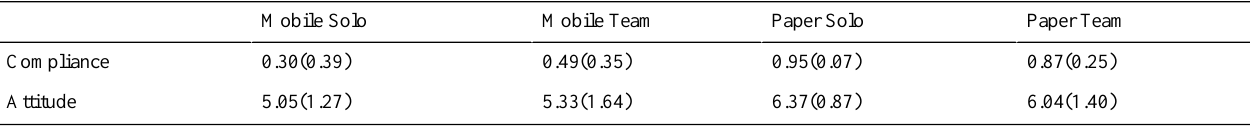
Table 2. Average compliance and attitudes and SD by